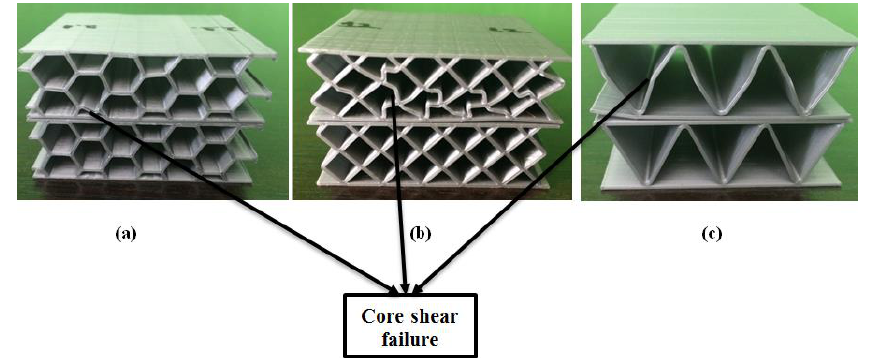
Figure 6. Core shear failures of the sandwich specimens subjected to flatwise compression tests: ( a ) honeycomb core sandwich specimens; ( b ) diamond-celled core sandwich specimens; ( c ) corrugated core sandwich specimens.